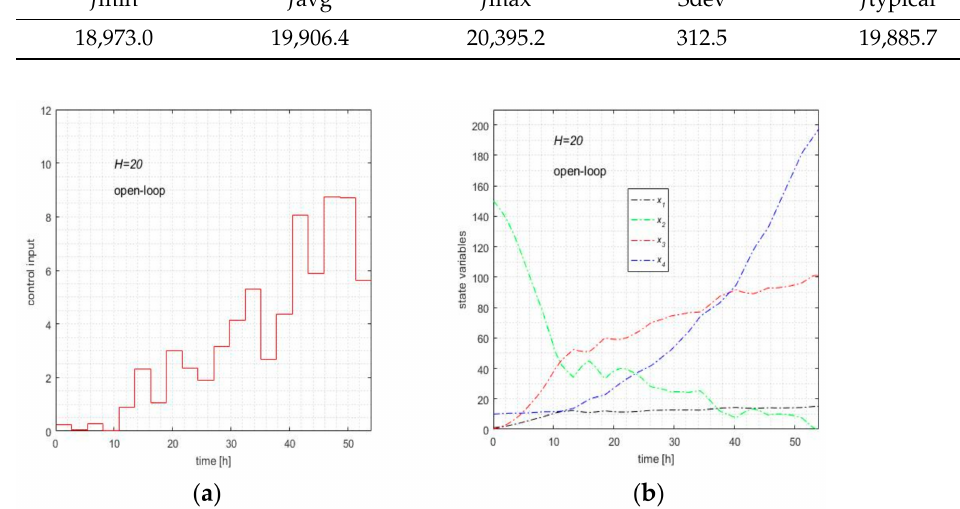
Figure 3. The typical solution given by the EA. ( a ) The quasi-optimal solution. ( b ) State evolution in open